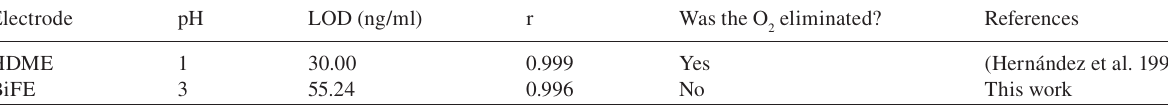
Table 1 Comparison of the effi ciency of the electrodes in the determination of ABA. Electrode